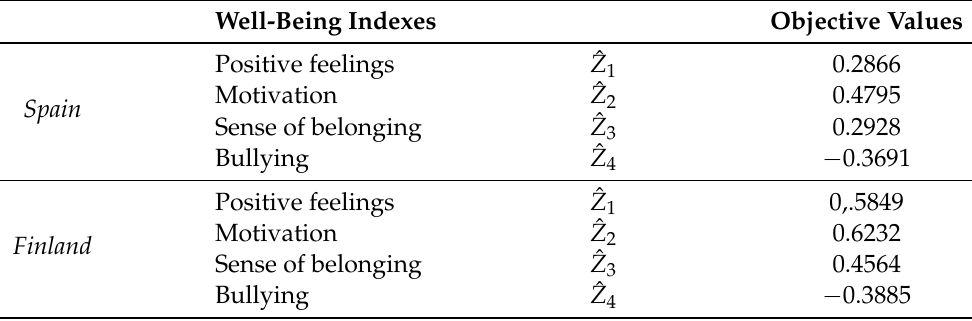
Table 14. Objective values at the Pareto optimal solutions obtained for the deterministic problems for Spain and